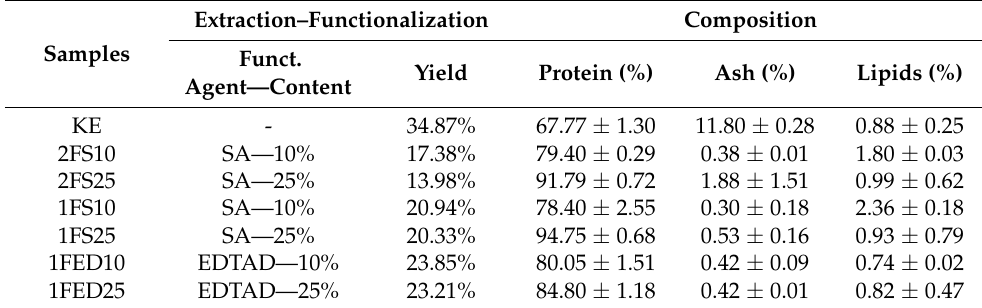
Table 1. Summary yield and composition of the different samples after functionalization with succinic anhydride (SA) or EDTAD at either 10 or 25 wt% of acylation agent content.